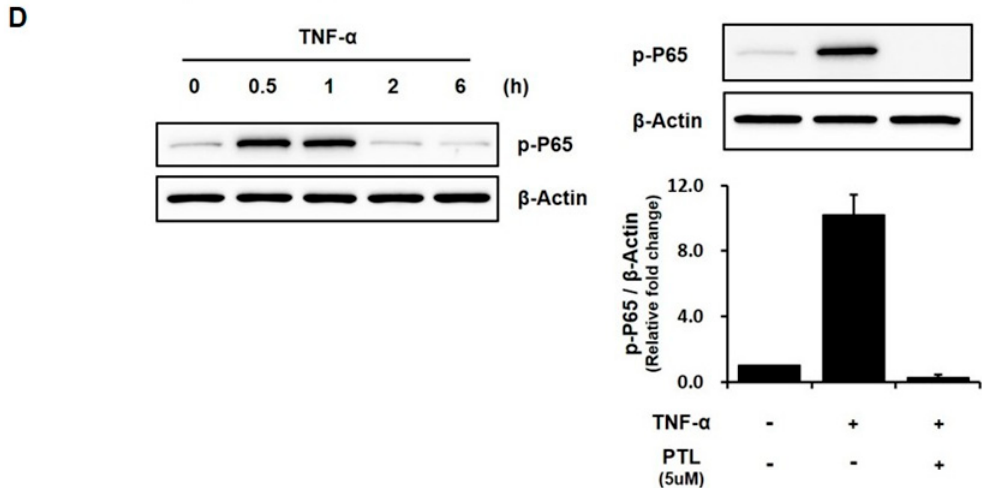
Figure 3. Effects of PTL on the osteogenic phenotypes of hPDCs treated with TNF- α . Treatment with 5 and 10 µM PTL significantly increased the histochemical detection and activity of ALP in hPDCs treated with TNF- α ( A ). The alizarin red-positive mineralization also appreciably decreased in hPDCs treated with 5 and 10 µM PTL ( B ). In addition, treatment with 5 and 10 µM PTL significantly decreased ALP mRNA expression in cells treated with TNF- α , at 1 and 2 weeks of culture, and decreased osteocalcin mRNA expression levels, at 4 weeks of culture, and decreased Runx2 mRNA expression levels, at 1, 2, and 4 weeks of culture ( C ). Treatment with TNF- α activated the phosphorylation of p65 in hPDCs, and PTL dramatically blocked the p65 phosphorylation in hPDCs treated with TNF- α ( D ). * p < 0.05. ** p < 0.01. *** p < 0.001.